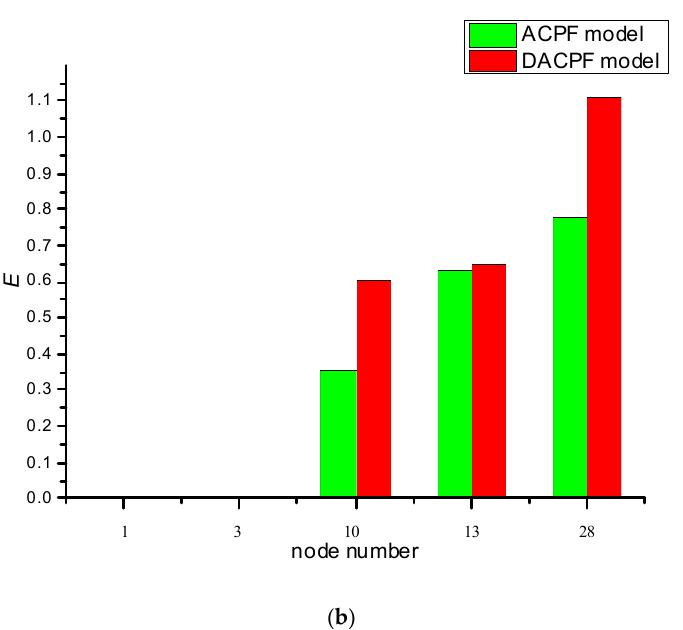
Figure 2. Contrastive analysis of the impacts of removing nodes, ( a ) Connectivity; ( b ) Global effective performance.